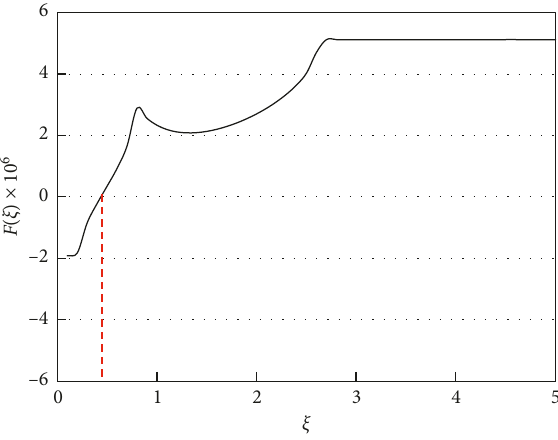
Figure 9: Function curve of F